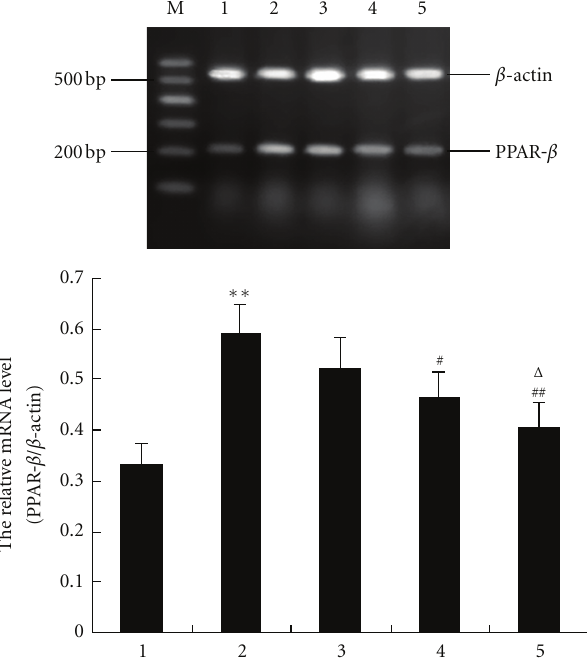
Table 2: E ff ect of GW0742 on the level of inflammatory factors in hippocampus of global cerebral ischemia/reperfusion rats. Group TNF- α (ng/mL) IL-1 β (pg/mL) IL-6 (ng/mL) IL-10 (ng/mL) Sham group 2 . 24 ± 0 . 51 209 . 14 ± 48 . 29 Model group 6 . 51 ± 1 . 05 ∗∗ 5 . 08 ± 0 . 64 # 452 . 20 ± 45 . 56 # 4 . 11 ± 0 . 58 ## / (cid:2) 369 . 99 ± 60 . 08 ## / (cid:2) 8 . 41 ± 1 . 06 ## / (cid:2) 2 . 72 ± 0 . 19 ## / (cid:2) Dates are expressed as mean ± SD ( n = 5). ∗∗ P < 0 . 01 compared with sham operation group; # P < 0 . 05, ## P < 0 . 01 compared with model group; (cid:2) P < 0 . 05 compared with GW0742 20 group.